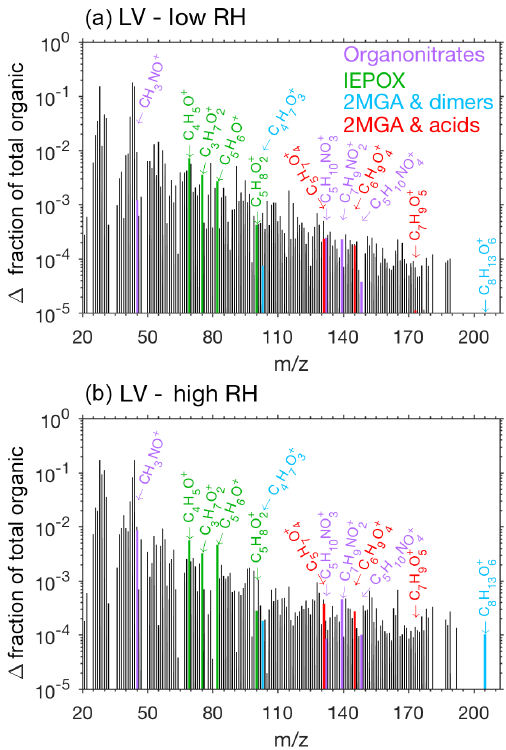
Figure 10. High-resolution AMS organic mass spectra (averaged over 10h of photooxidation – the sulfate background) for exper- iment M2 (RH = 9%, panel a ) and M8 (RH = 81%, panel b ) in gray. Fragments are labeled as 2-MGA monomer or dimer (cyan), esterification of 2-MGA with acids (red), examples of organosulfate fragments (dark green), and examples of organonitrate fragments – C x H y NO z